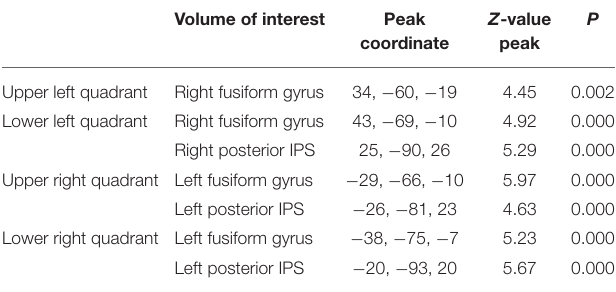
TABLE 4 | Univariate results with small volume correction.